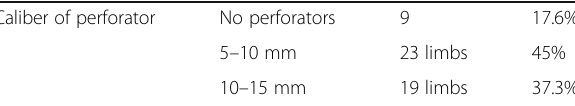
Table 6 The caliber of the treated